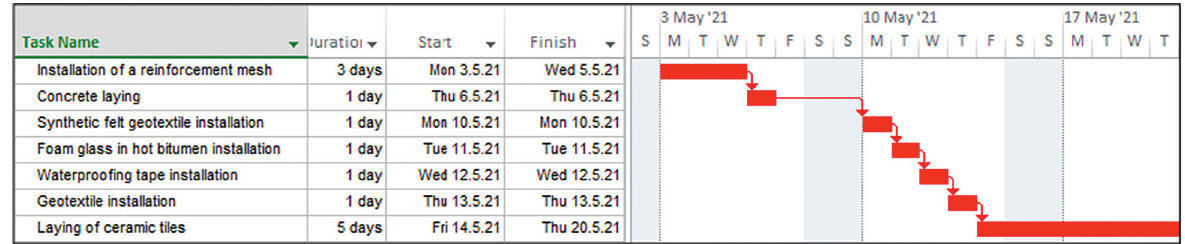
Figure 3: Conventional flat roof Gantt chart (the figure is created by authors upon data collected from cost estimate for the building under construction).